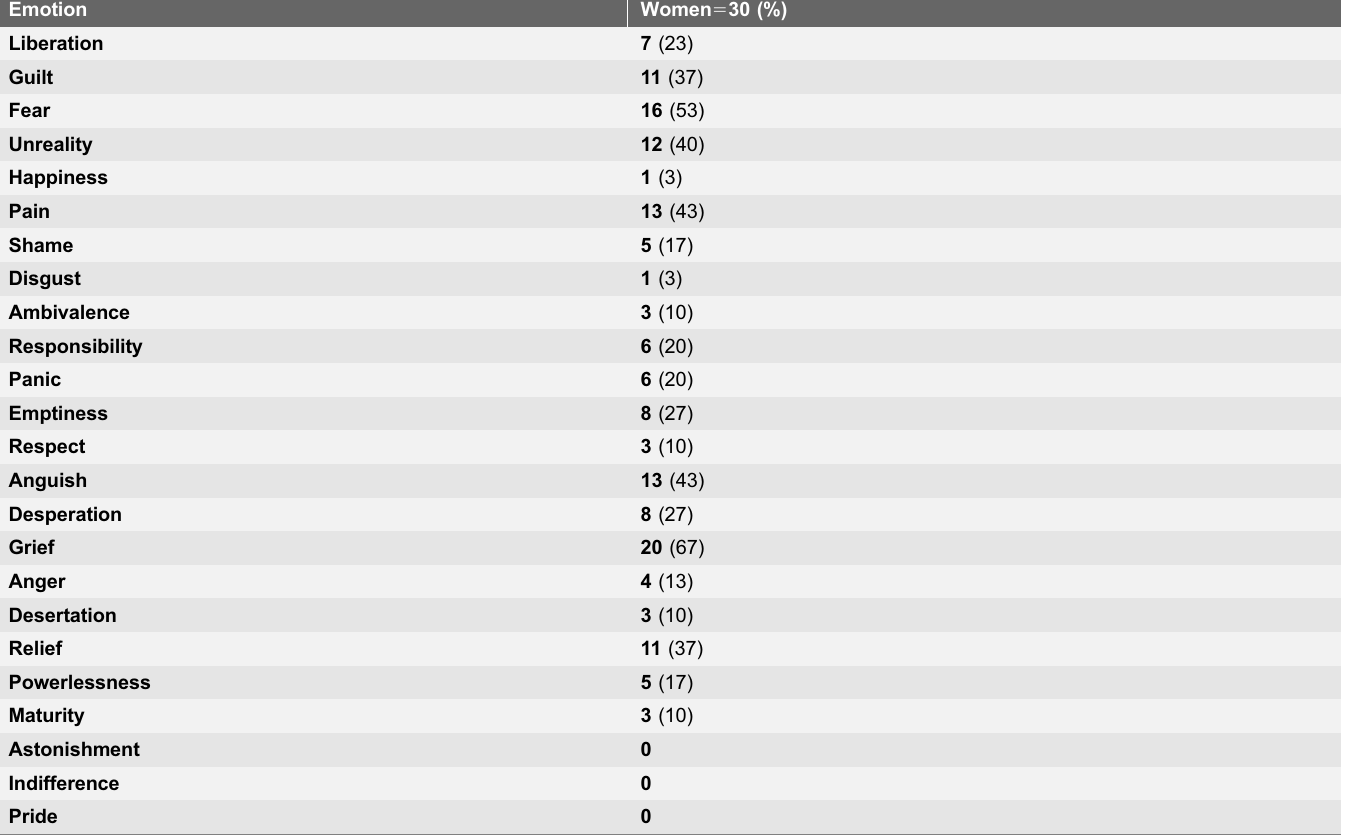
Table 1. Emotions prior to the abortion selected by participants from the